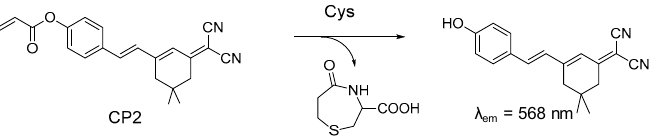
Figure 13. Response mechanism of CP2 to Cys [69].